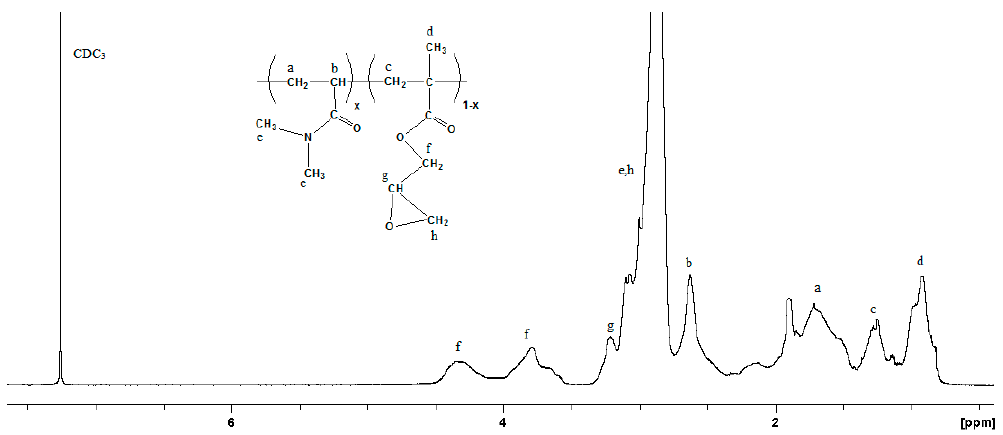
Figure 2. 1 H NMR spectrum of the P(DMAm-co-GMA30) copolymer in CDCl 3